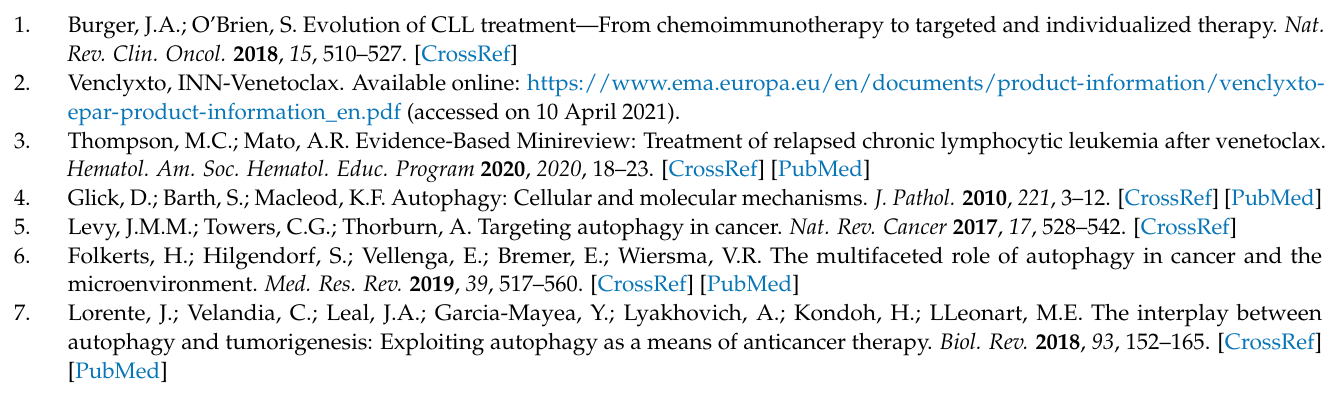
hLC3 cell line, Figure S2: Autophagy inhibitor bafilomycin A1 blocks proliferation of MEC-1 cells, Figure S3: Cell cycle phase distribution in MRT68921-treated MEC-1